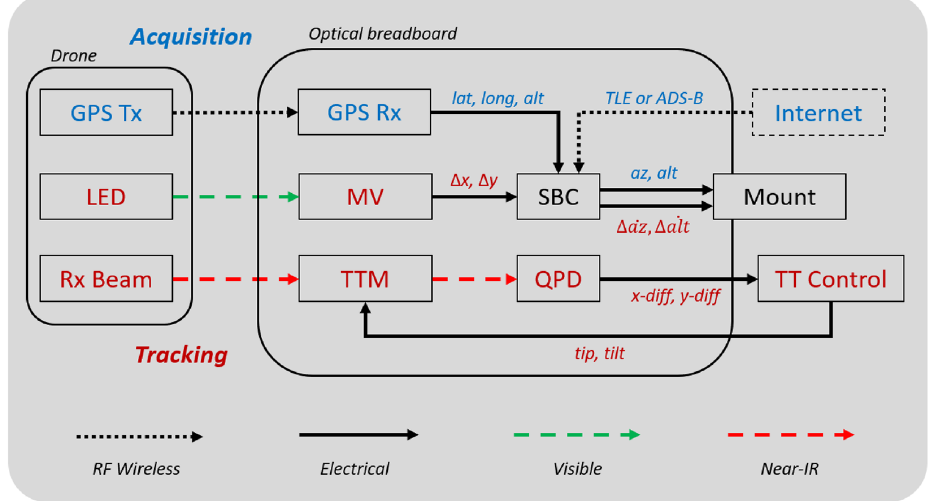
Figure 3. Block diagram showing interfaces between components during initial acquisition (blue) and continous tracking